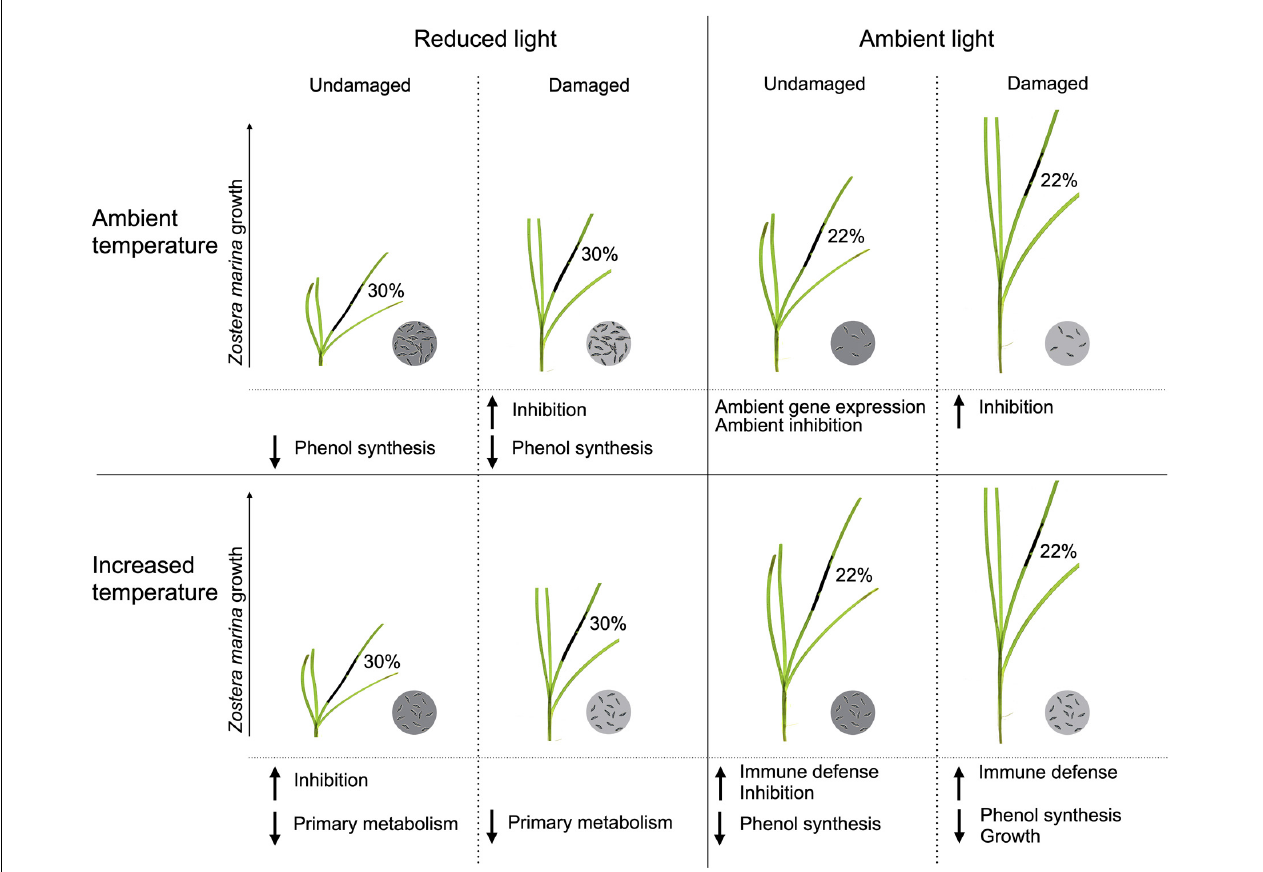
FIGURE 7 | Summarized effects of light, temperature and tissue damage on the host-pathogen interaction between Zostera marina and Labyrinthula zosterae following 7 days of L. zosterae inoculation. The significant effects on lesion coverage, L. zosterae cell concentration, Z. marina growth, chemical defense, and gene expression demonstrated in Figures 2–6 and Table 5 are shown. Mean lesion coverage are given in percentage. L. zosterae cell concentration are indicated by the circles with L. zosterae cells: ambient = 6 cells, increased = 24 cells, intermediate = 12 cells, dark gray circles have significantly higher cell concentration than light gray circles for each light/temperature combination. L. zosterae growth inhibition by Z. marina extracts, and up or downregulation of gene groups in relation to undamaged Z. marina shoots at ambient light/ambient temperature are shown below each